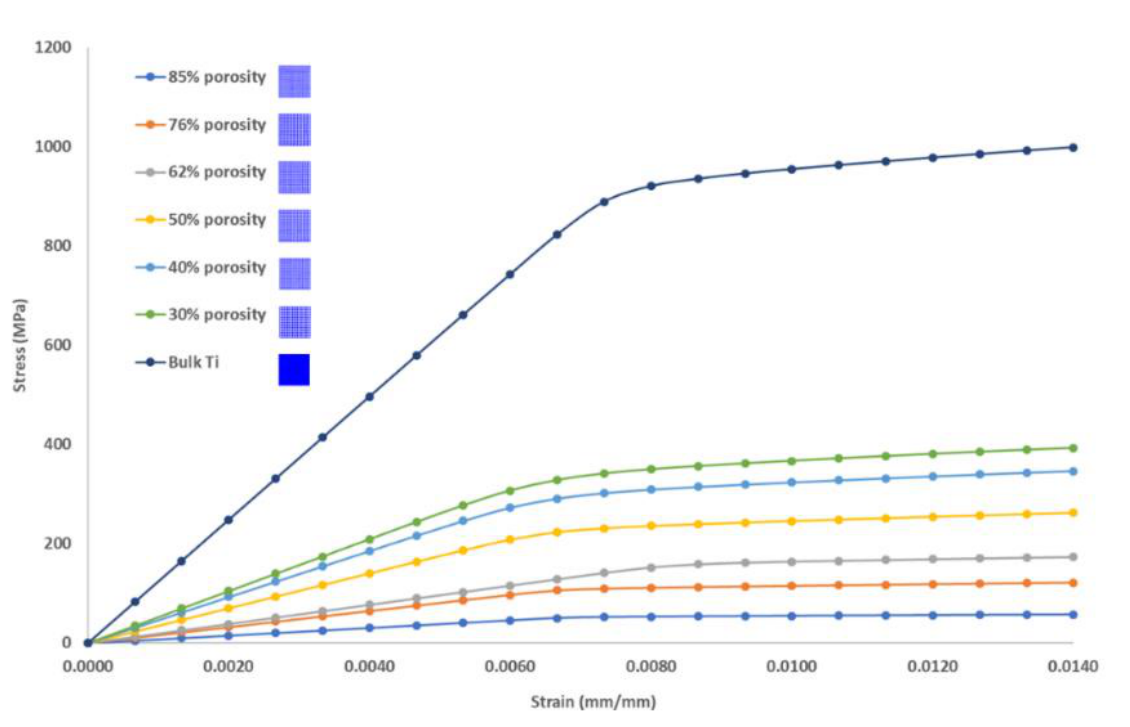
Figure 7. Stress – strain diagram for the designed porous cubes with relevant volumetric porosities.